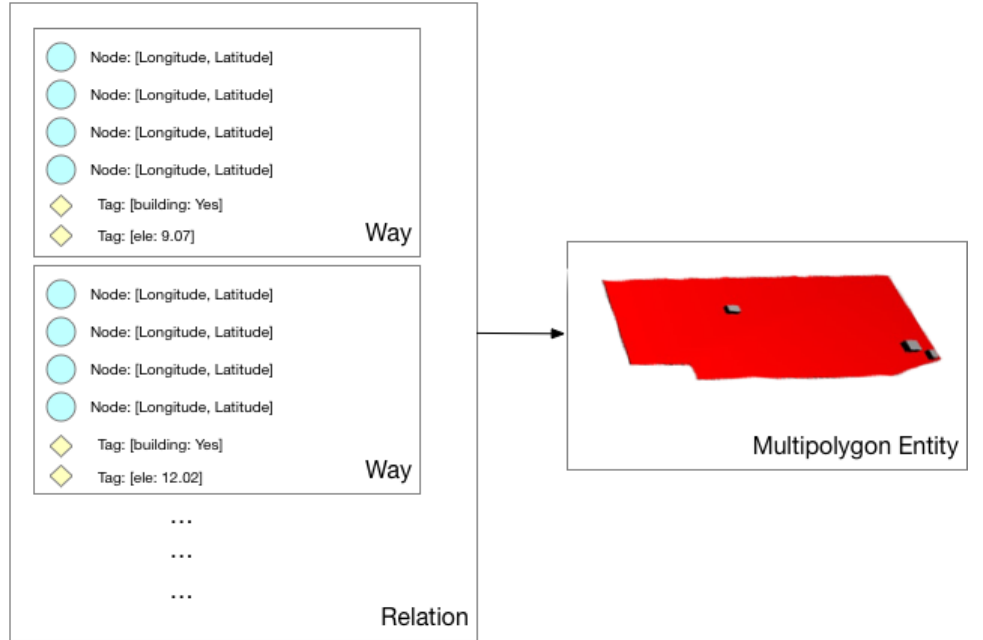
Figure 4. A Multipolygon construct defined by relations, ways, nodes and